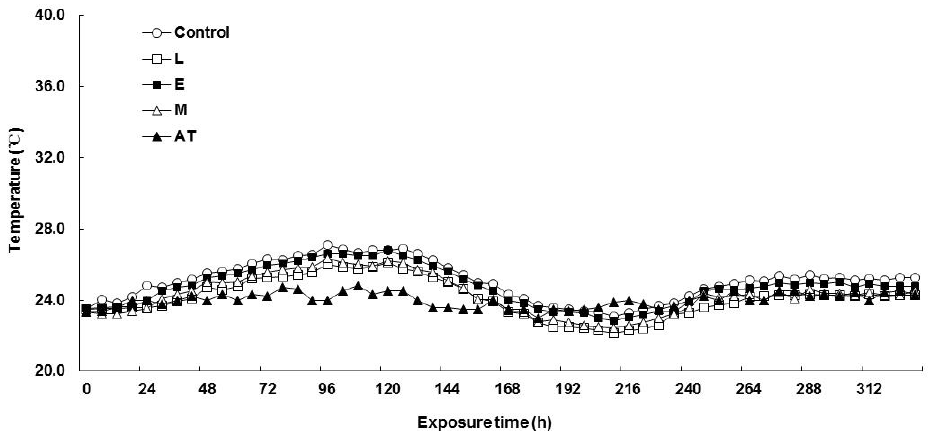
Figure 1. Effect of application of additives on the temperature change of Flammulina velutipes spent mushroom substrate silages after exposure to aerobic conditions. L, lactic acid bacteria; E, cellulase; M, the mixture of lactic acid bacteria and cellulase; AT, ambient temperature.